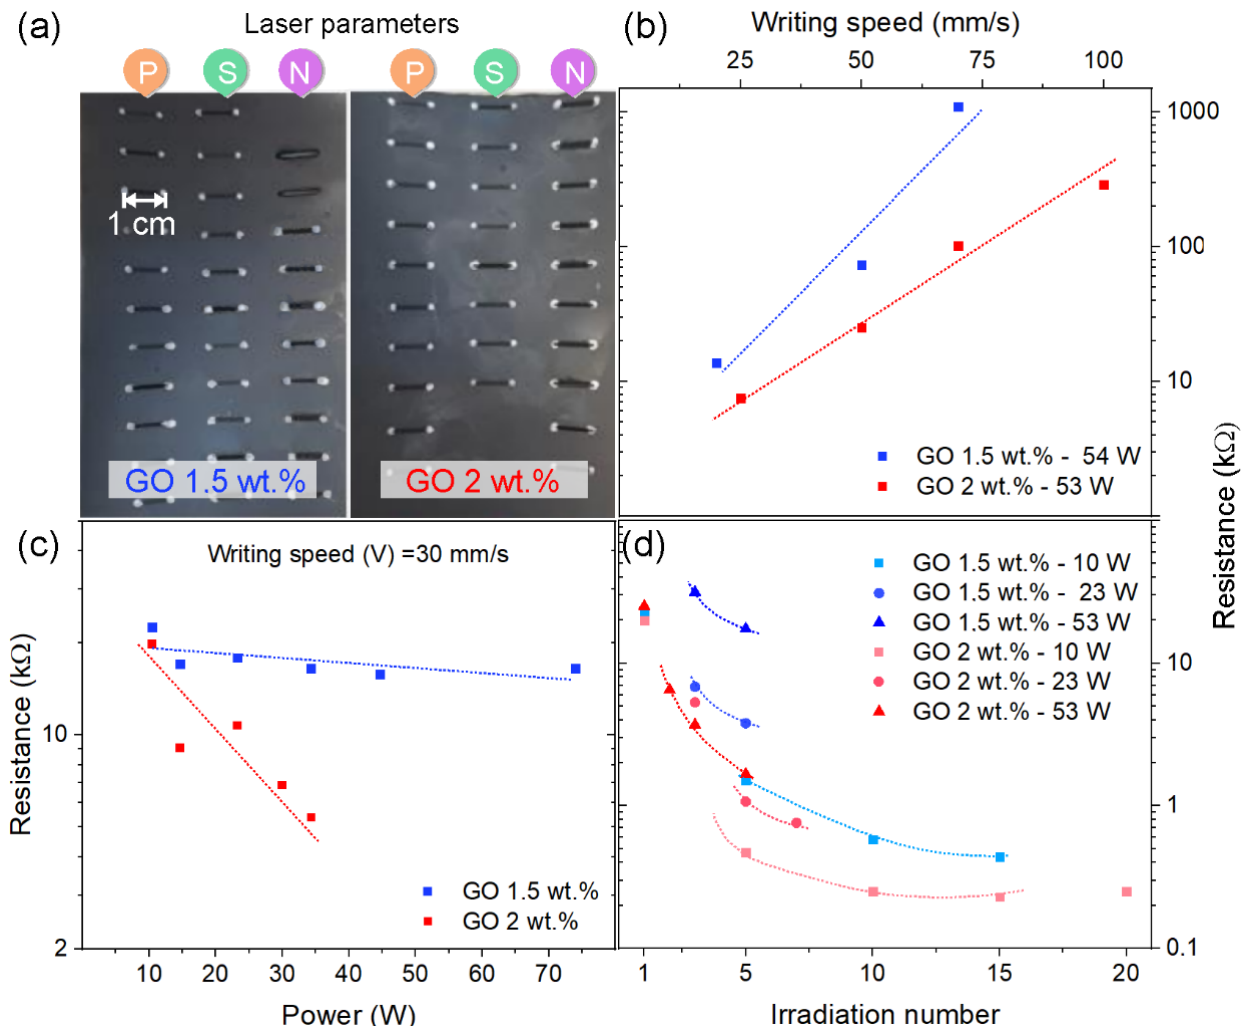
Figure 3. Effect of laser processing parameters (P: laser power; S: writing speed, and N: irradiation number): ( a ) pictures of 10 mm paths obtained on GO-loaded PU layers (GO 1.5 wt.% and GO 2 wt.%); ( b – d ) electrical resistance (R) for the 10 mm long paths fabricated by changing different writing speeds, laser powers, and number of irradiations along the same path, respectively.